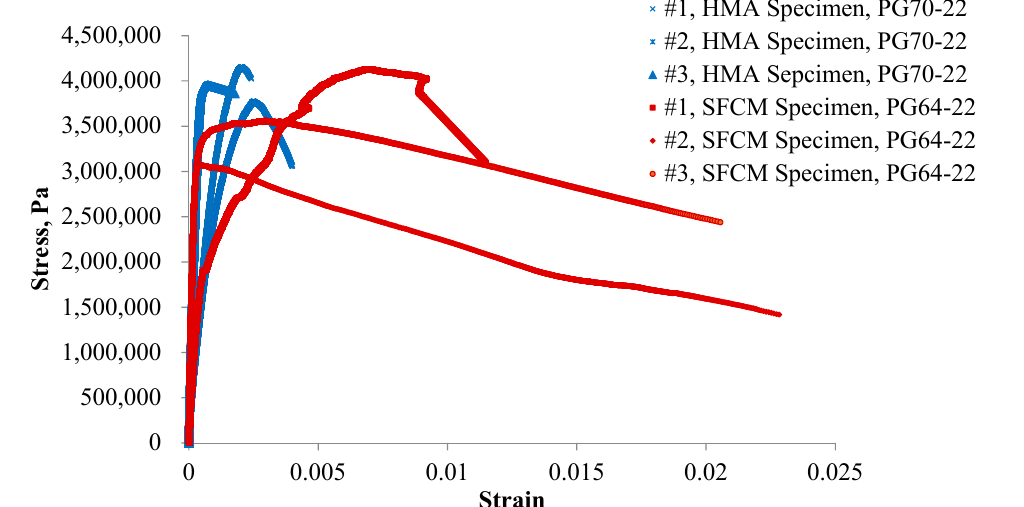
Figure 6. Stress-strain relationship of thermal cracking testing. Table 3. Summary of fracture work and maximum stress ( − 10 °C).